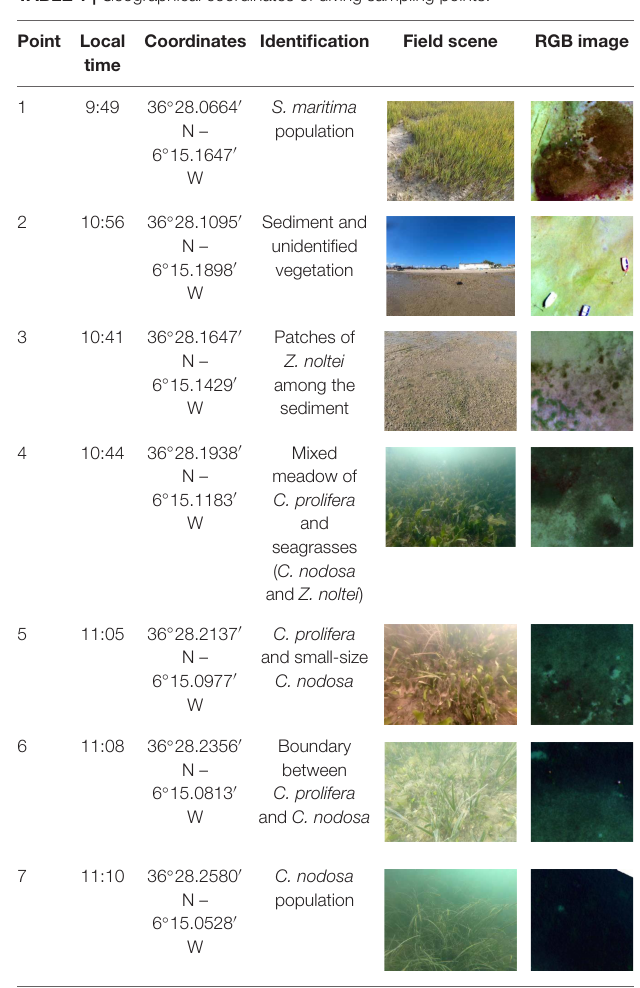
TABLE 1 | Geographical coordinates of diving sampling